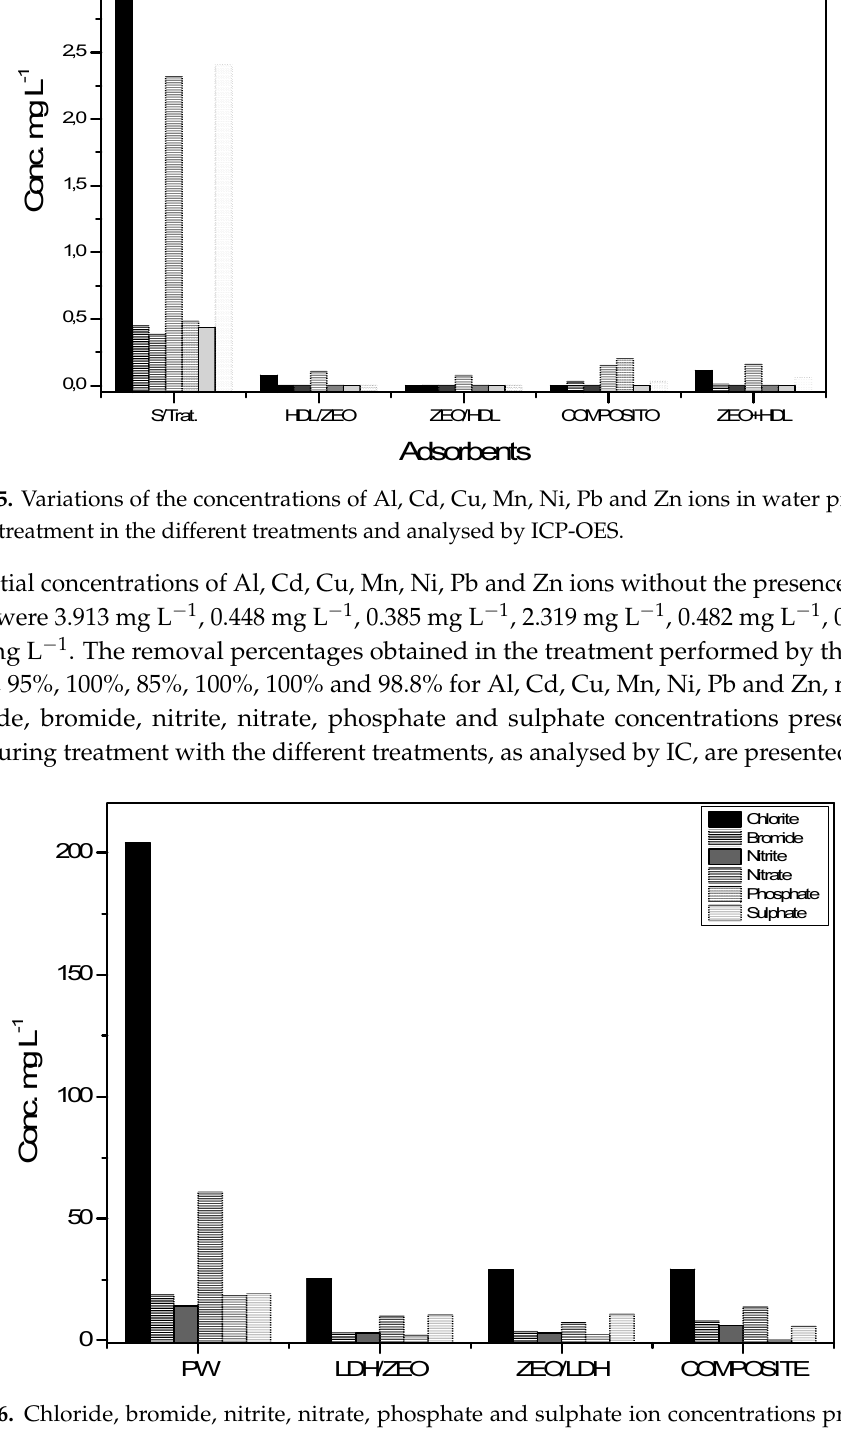
water produced during treatment with the different treatments, as analysed by IC. Figure 6. Chloride, bromide, nitrite, nitrate, phosphate and sulphate ion concentrations present in